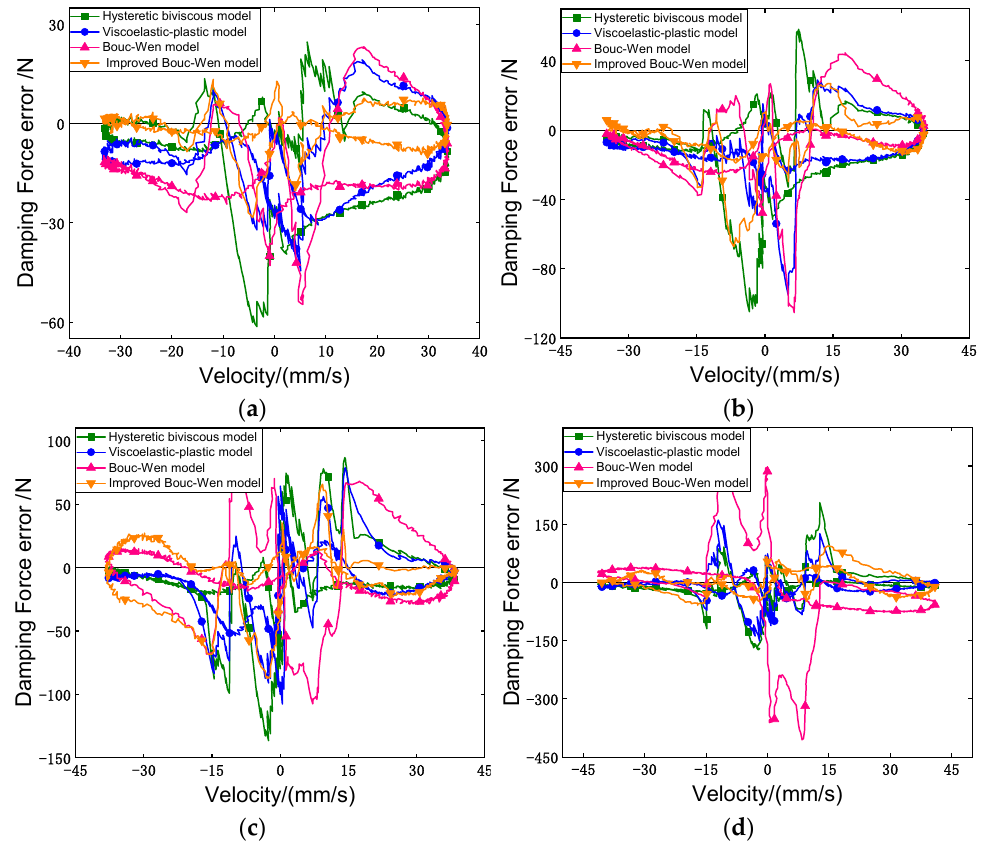
Figure 6. Damping force errors of four models at different current values. ( a ) The damping force error at 0 A; ( b ) The damping force error at 0.2 A; ( c ) The damping force error at 0.4 A; and ( d ) the damping force error at 0.6 A.